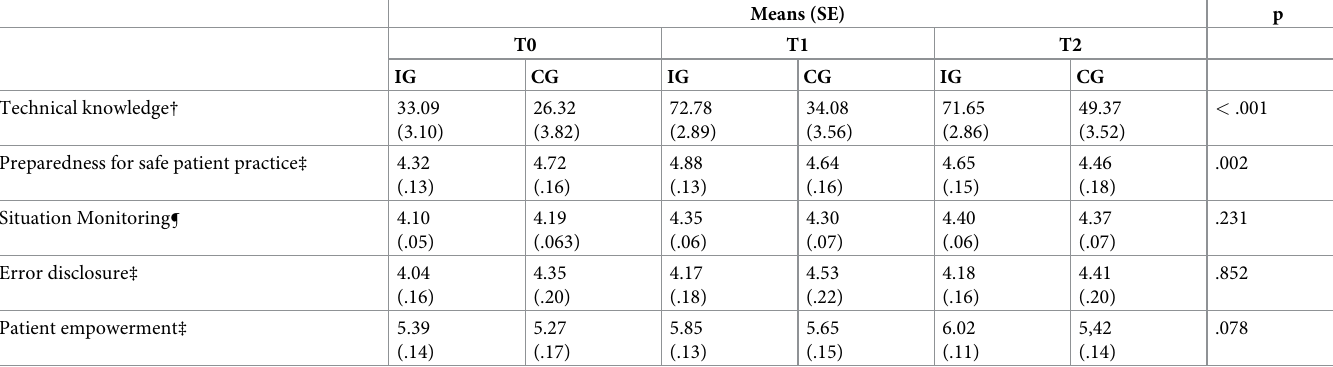
Table 2. Univariate statistics for variables in analysis. IG = intervention group; CG = control group.